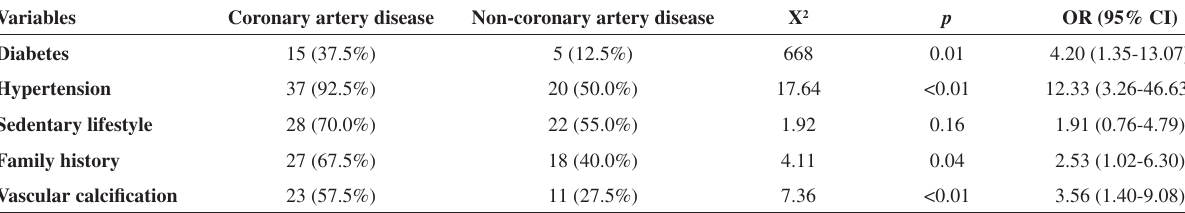
Table 1 – Univariate analysis of factors presumed to present a risk for coronary artery disease